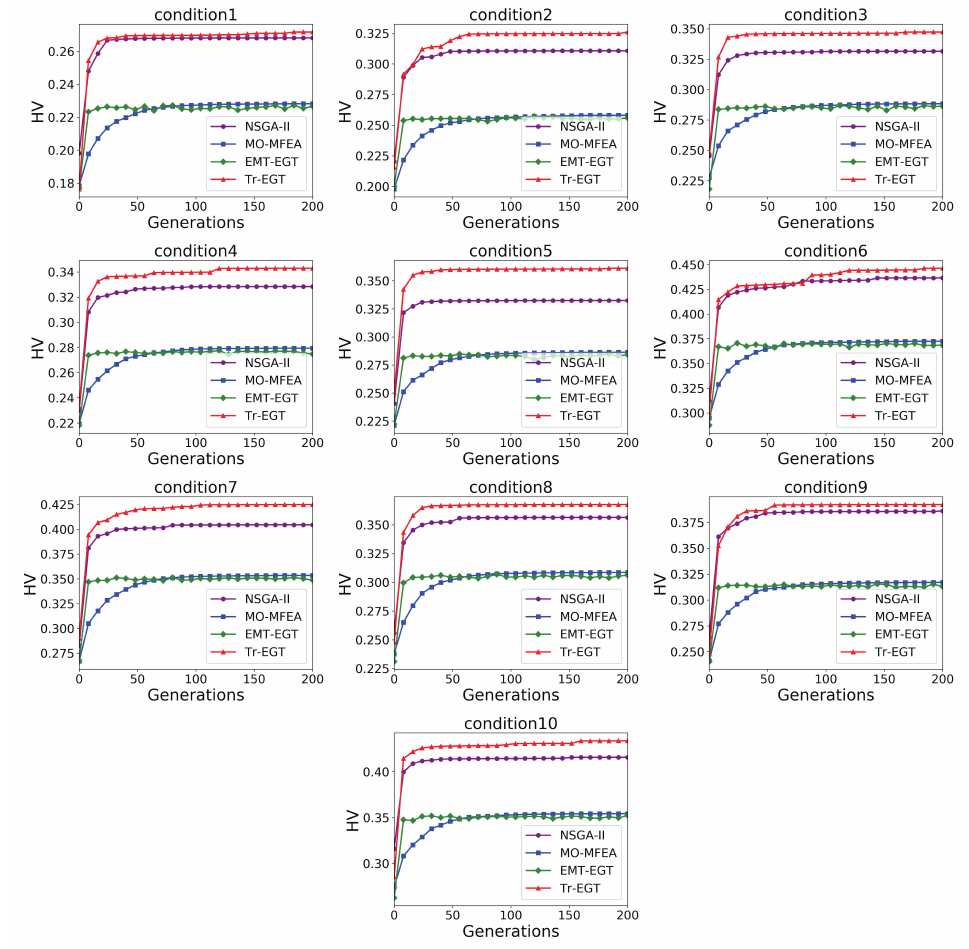
Figure 5. Average HV numerical curves of NSGA-II, MO-MFEA, EMT-EGT and Tr-EGT over 20 independent runs on task 2